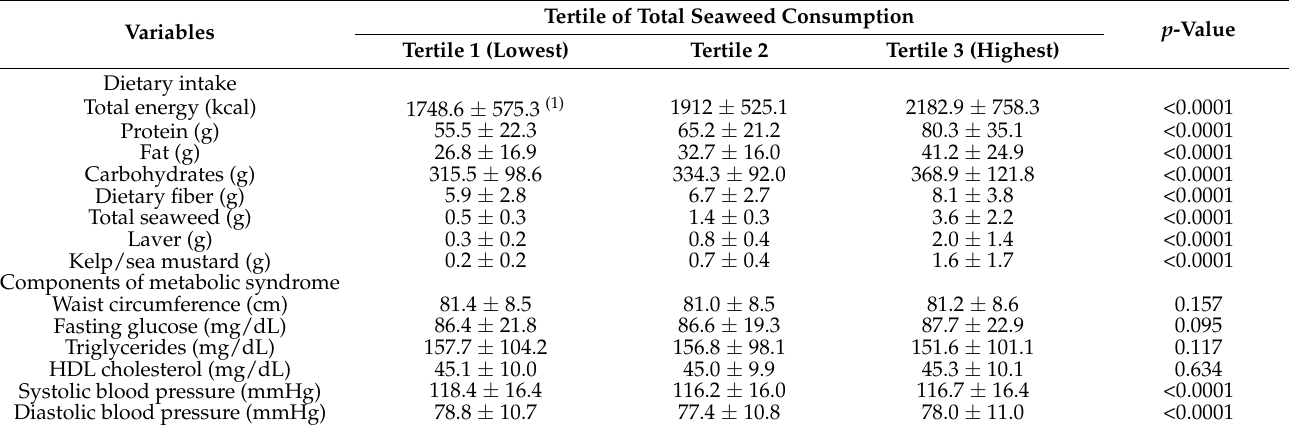
Table 2. Dietary intake and clinical characteristics according to tertiles of total seaweed consumption in the Korean Genome and Epidemiology Study (Ansan and